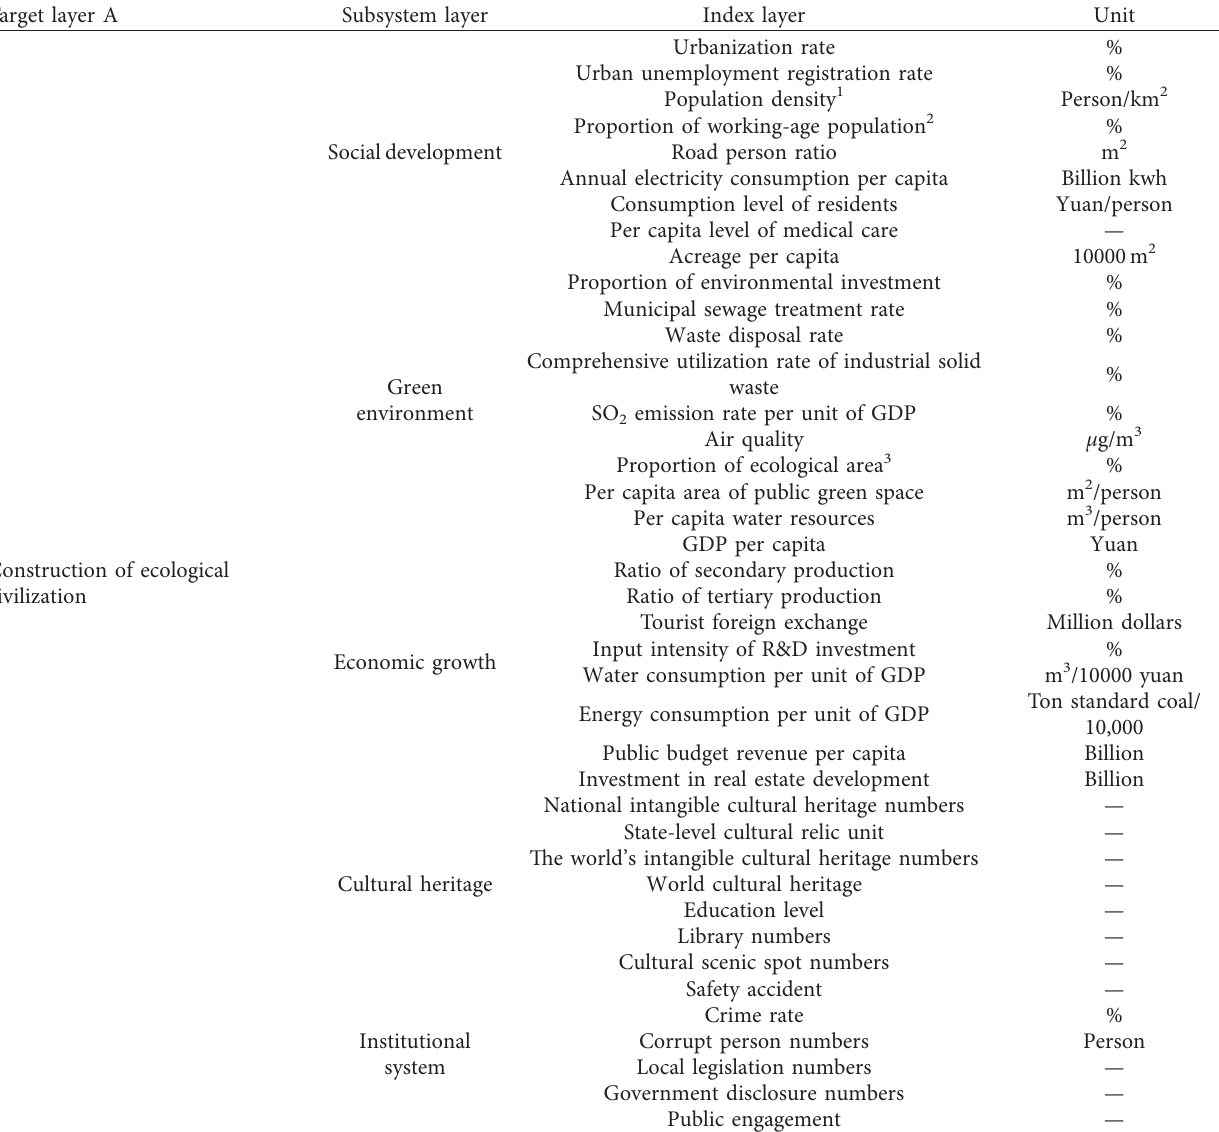
Table 1: Evaluation index system of ecological civilization